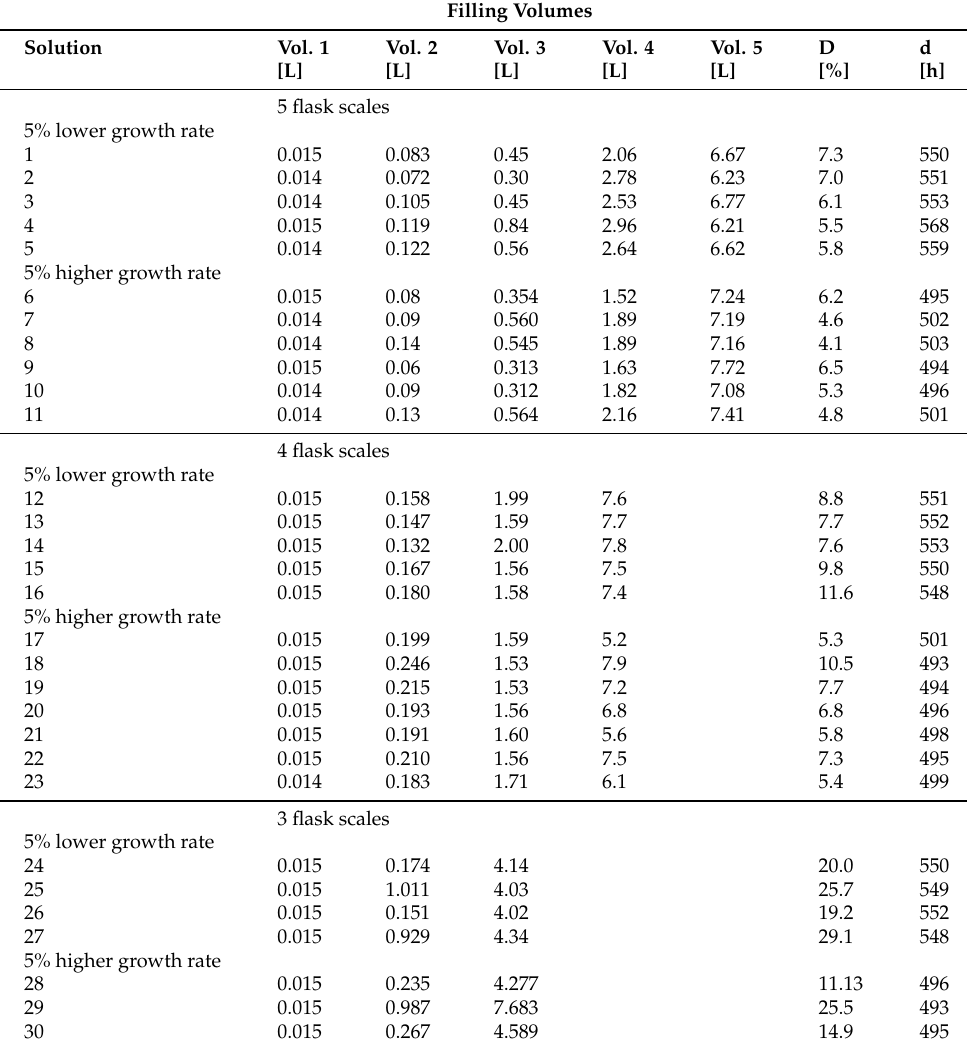
Table 5. Pareto optimal solutions concerning the choice of filling volumes in shake flask scales, for 3, 4 and 5 shake flask scales, for two different scenarios. Scenario 1 assumes a 5% lower and scenario 2 a 5% higher cell-specific maximum growth rate compared to the reference maximum growth rate. The bioreactor filling volumes which follow after the shake flask scales are 40 L, 320 L and 2210 L. The filling volumes in L, the resulting deviation rate ( D ) in % and seed train duration ( d ) in h are listed for each solution (several Pareto optimal solutions can be obtained per